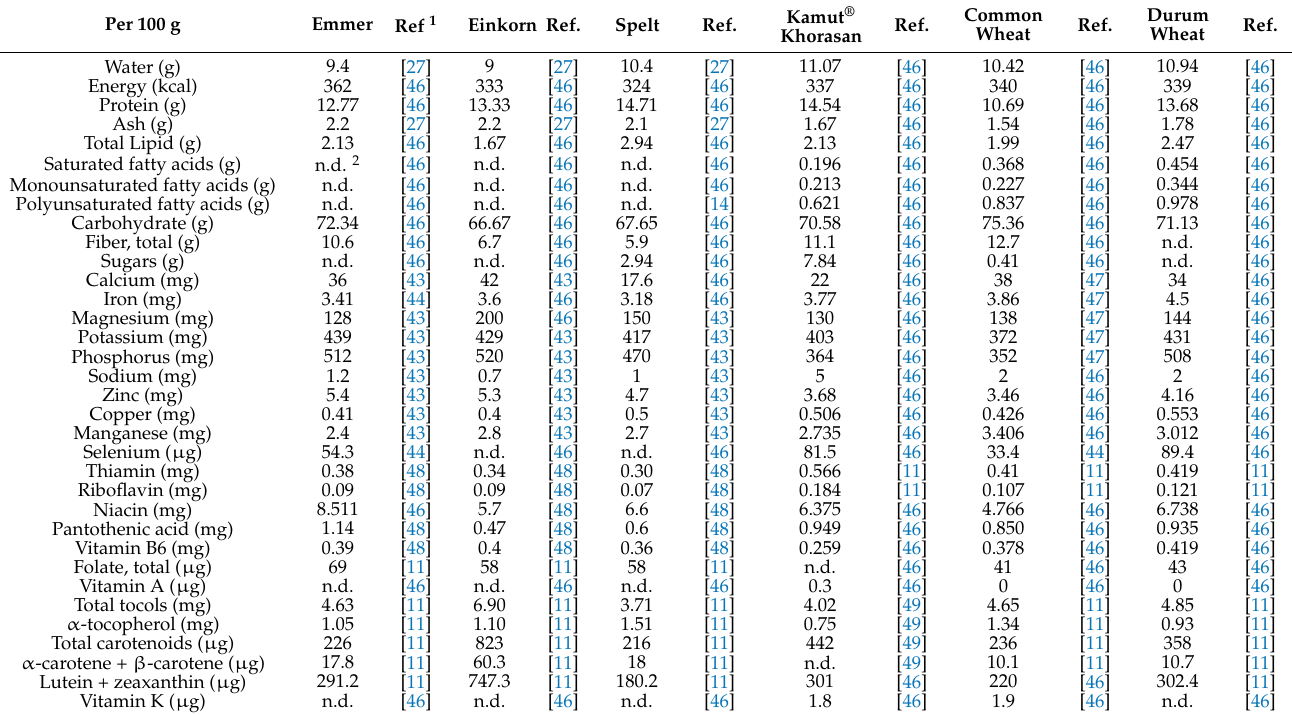
Table 2. Approximate chemical composition for ancient (emmer, einkorn, spelt, Khorasan) and modern (common and durum wheat) whole grains (expressed as g or mg/100 g dry